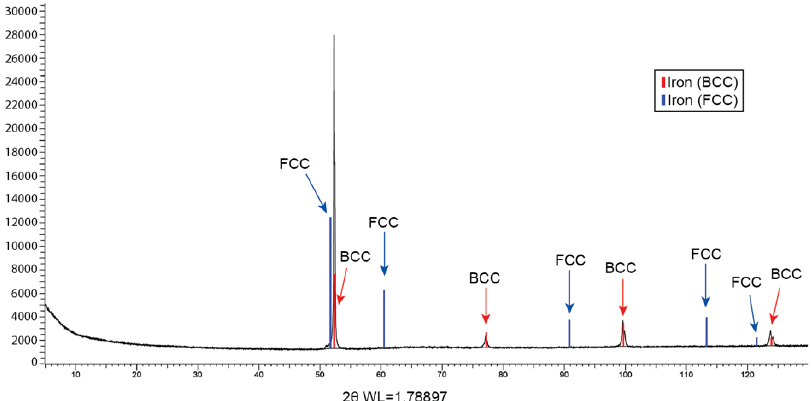
Figure 6. XRD analysis on sample 3-wt% Ni DP_70%. Red and blue lines indicate the angles corresponding to BCC (ferrite or martensite) and FCC (retained austenite), respectively. The absence of peaks matching with blue lines indicates that no retained austenite was found.